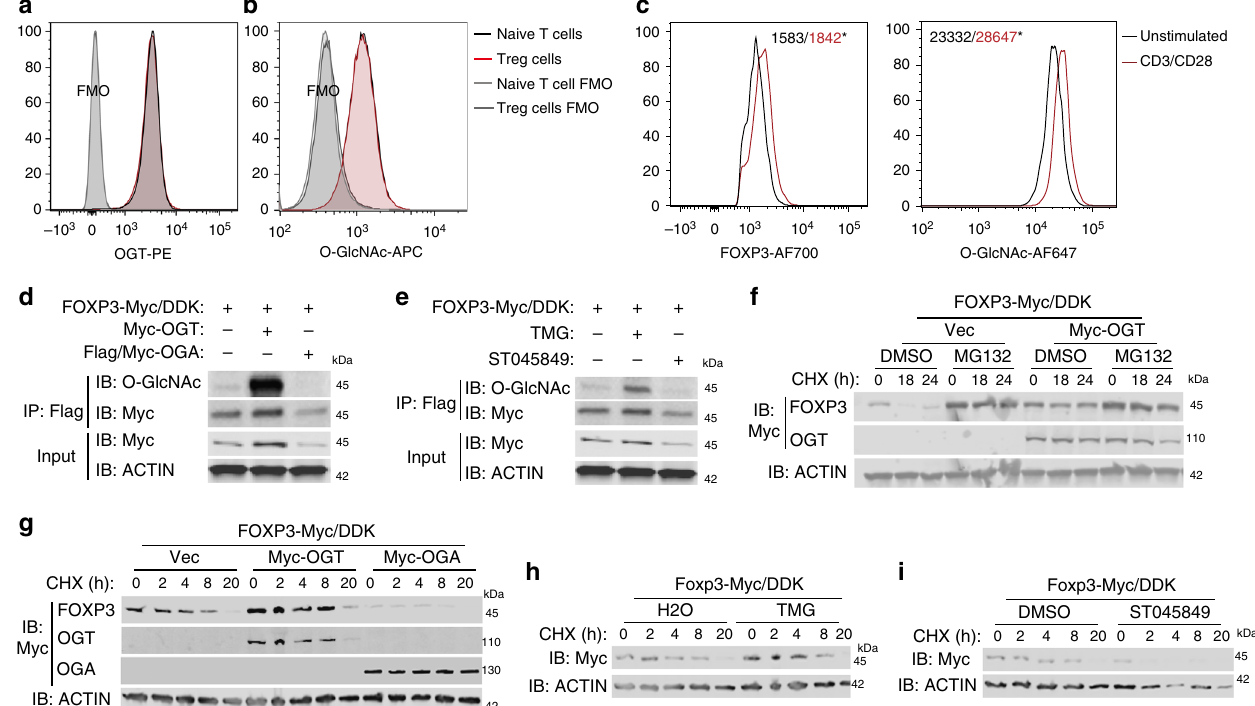
The absolute numbers of CD4 + and CD8 + T cells were increased in the lymph nodes (LNs) of Foxp3 YFP-Cre/Y Ogt fl /Y mice (Supplementary Fig. 3B). The percentage of effector/memory cells (CD44 hi CD62L lo ) within the CD4 + and CD8 + compart- ments were consistently higher in both the LNs and the spleen of Foxp3 YFP-Cre/Y Ogt fl /Y KO mice than those in Foxp3 YFP-Cre/Y Ogt wt/Y controls (Fig. 3f, g). B cell frequency in the LNs and levels of IgG, IgM, and free kappa and lambda chains in the serum were upregulated in KO mice (Supplementary Fig. 3C, D).